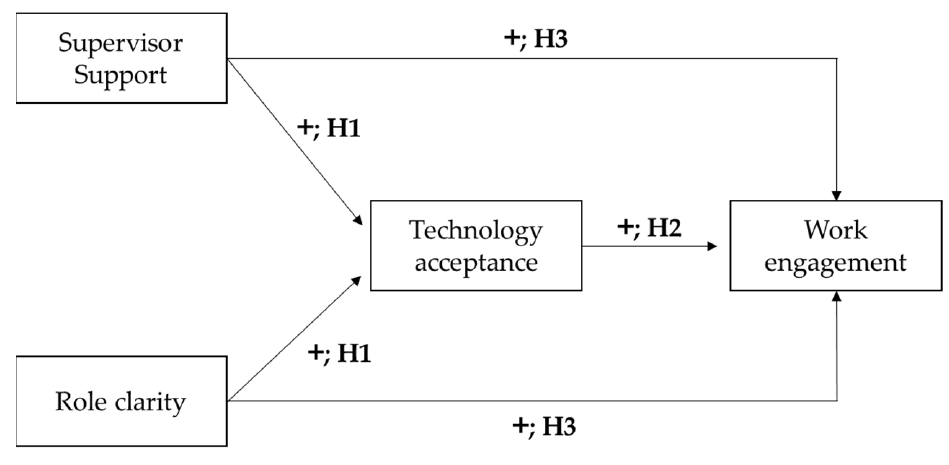
Figure 1. The hypothesized model. Hypothesis 3 (H3). technology acceptance is positively related to work engagement. Hypothesis 4 (H4). technology acceptance partially mediates the relationship between job resources (supervisor support and role clarity) and work